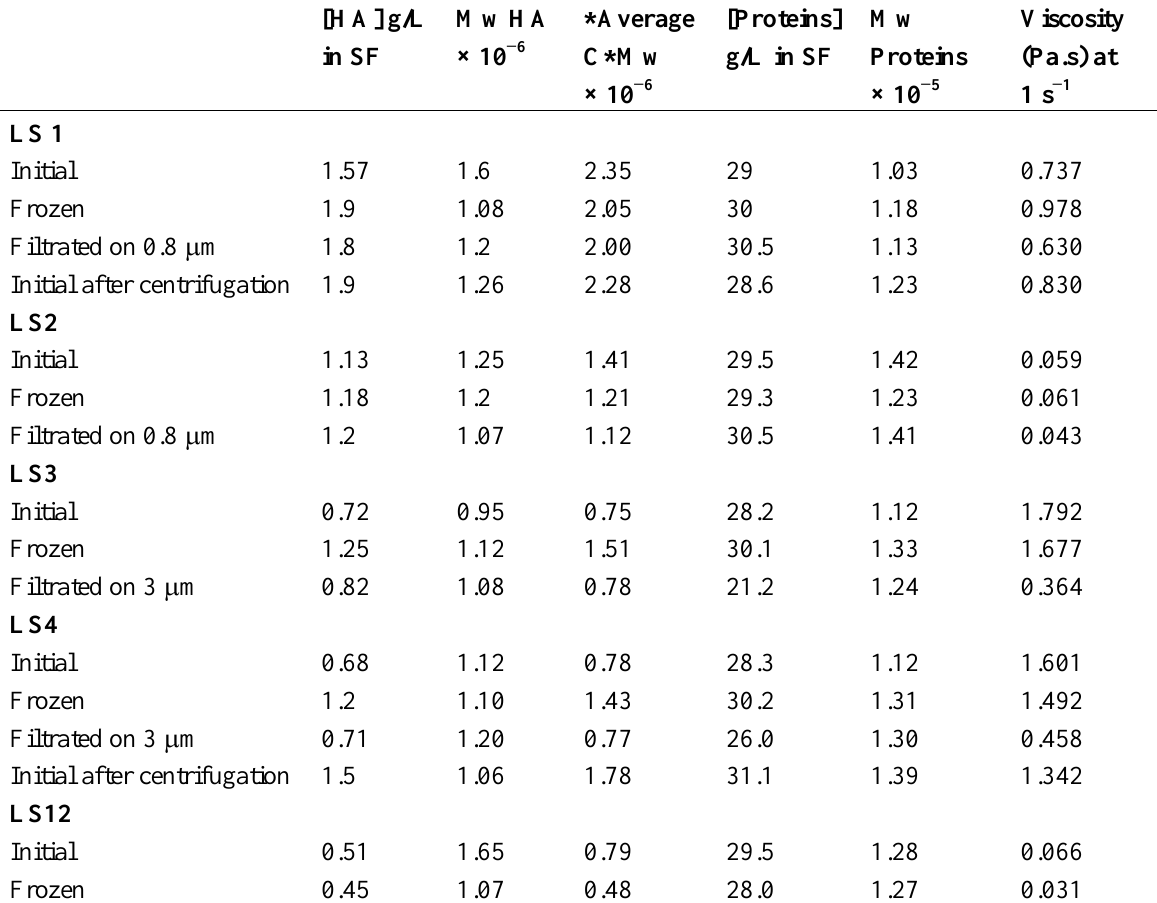
Table 1. Characteristics of different synovial fluids obtained by SEC after different pre-treatments.